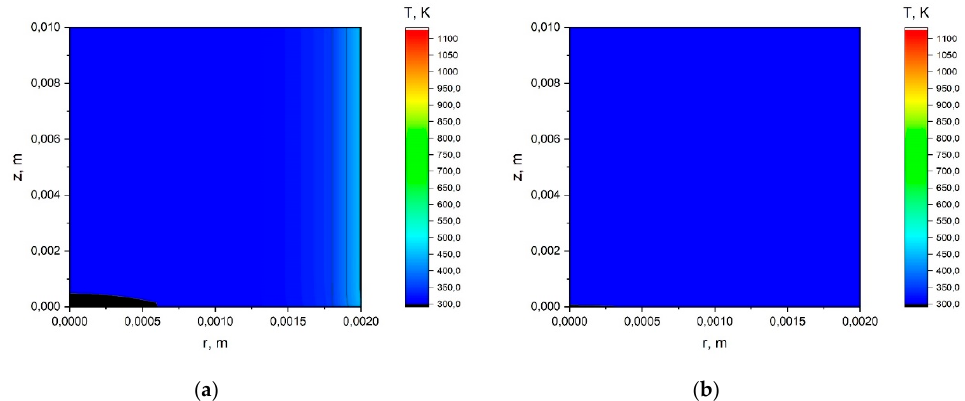
Figure A2. Temperature distribution in the stem of a herbaceous plant: R = 0.002 m, t = 0.5 s, q = 30 kW/m 2 ( a ); R = 0.002 m, t = 3 s, q = 0.5 kW/m 2 ( b ).